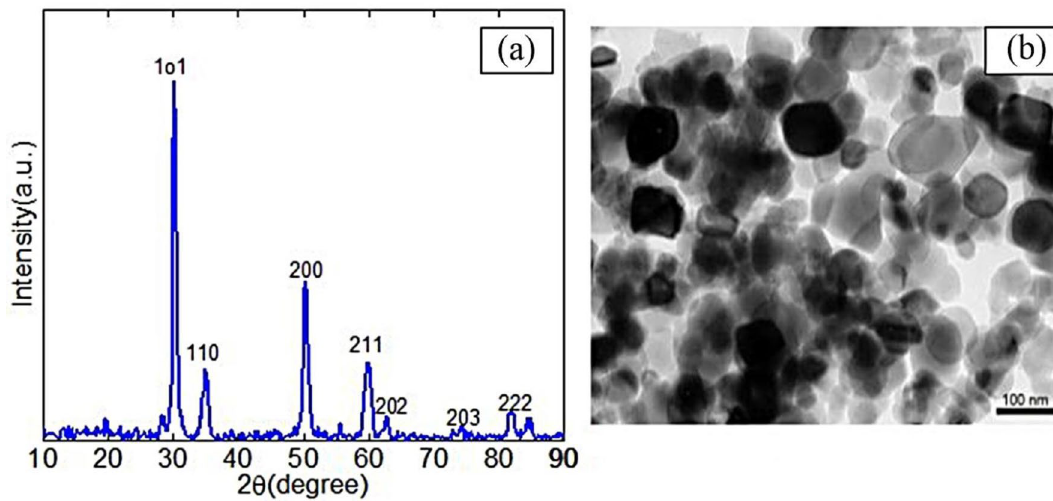
Fig. 3 a XRD pattern and b TEM image of the yttria-stabilized zirconia